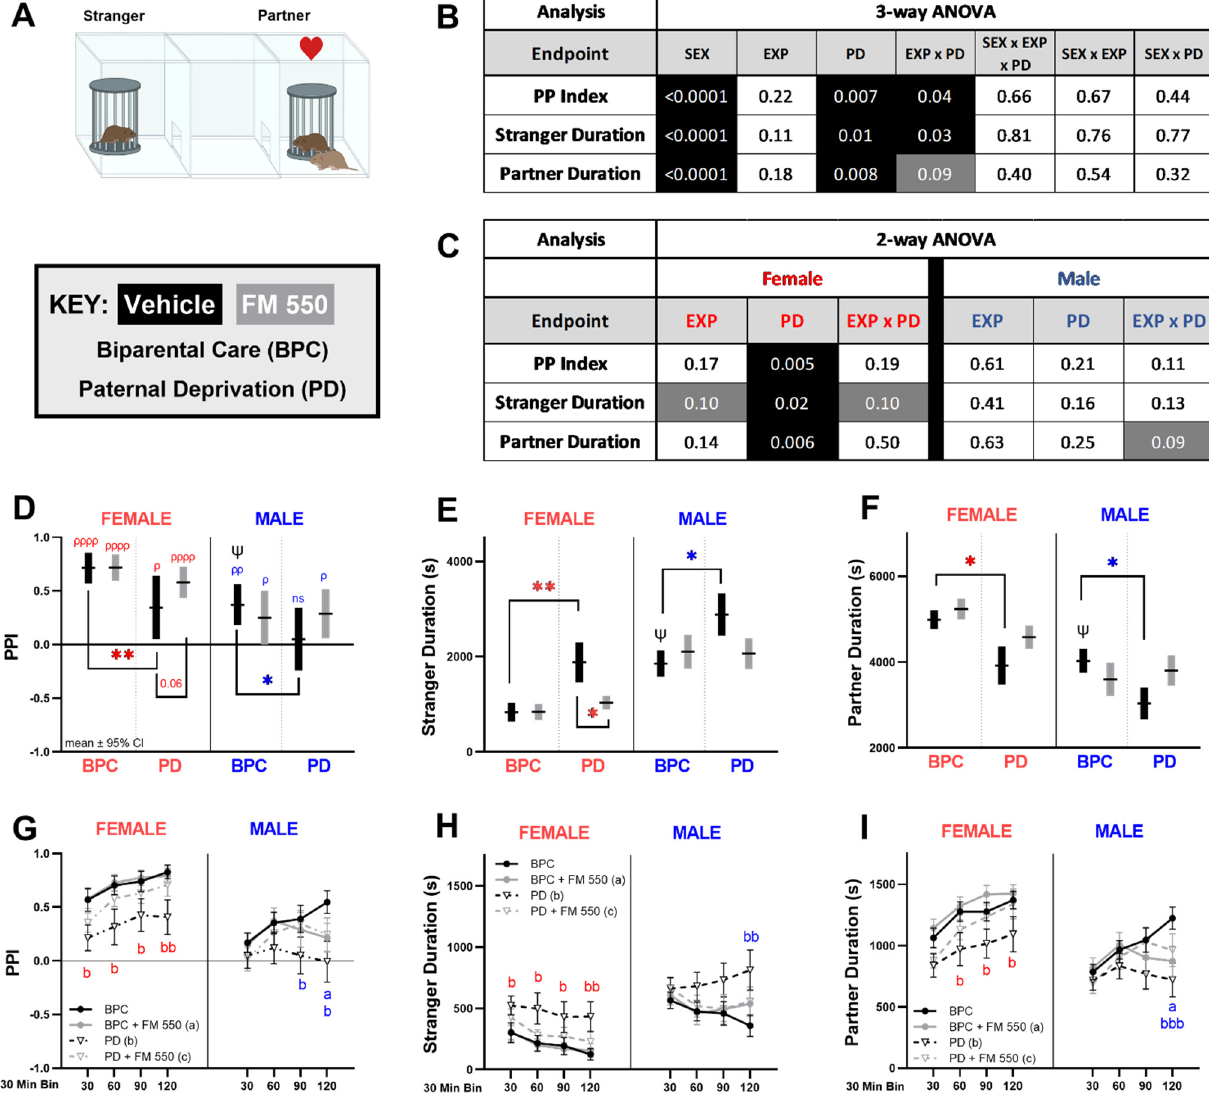
Figure 4. Social endpoints in the partner preference test. ( A ) Schematic depicting the placement of the partner and stranger animals in the three-chamber arena. ( B ) Three-way ANOVA p -values for main effects of sex, exposure, paternal deprivation, and interaction for each endpoint. Significant effects are highlighted in black and suggestive effects ( p ≤ 0.10) are highlighted in grey. ( C ) Two-way ANOVA p -values within sex. ( D ) Partner preference index, calculated over the entire 2 hrs, was sexually dimorphic and paternal deprivation significantly lowered PPI in both unexposed groups (male and female). Only the PD males did not show a partner preference. ( E ) Time spent with the stranger was sexually dimorphic and PD females and males spent more time with the stranger than their BPC counterparts. FM 550 PD females spent significantly less time with the stranger than PD only females. Similar findings were found for partner duration ( F ), with PD males and females spending less time with their partners than BPC controls of the same sex. Endpoints were also binned into 30-min intervals ( G – I ) to explore PP behavior over time. Notably, PPI and partner duration tended to increase with time in the BPC groups, but this pattern was not seen in the PD males. Graphs ( E – I ) depict mean ± SEM and ( D ) depicts mean ± 95% CI. For each dose ( n = 14–23), * denotes statistically significant exposure effects within sex, while ψ denotes significant sex differences between unexposed BPC animals. For PPI ( D ), a significant difference from equal preference (PPI = 0, solid line) is indicated by ρ . A lack of significant difference is indicated by ns. A partner preference index of 1.0 indicates a maximal preference for a partner, while an index of − 1.0 indicates a maximal preference for the stranger. For binned data ( G – I ), significant group differences at individual time points are depicted by letters (a: BPC + FM 550; b: PD; c: PD + FM 550); circles with solid lines = BPC,